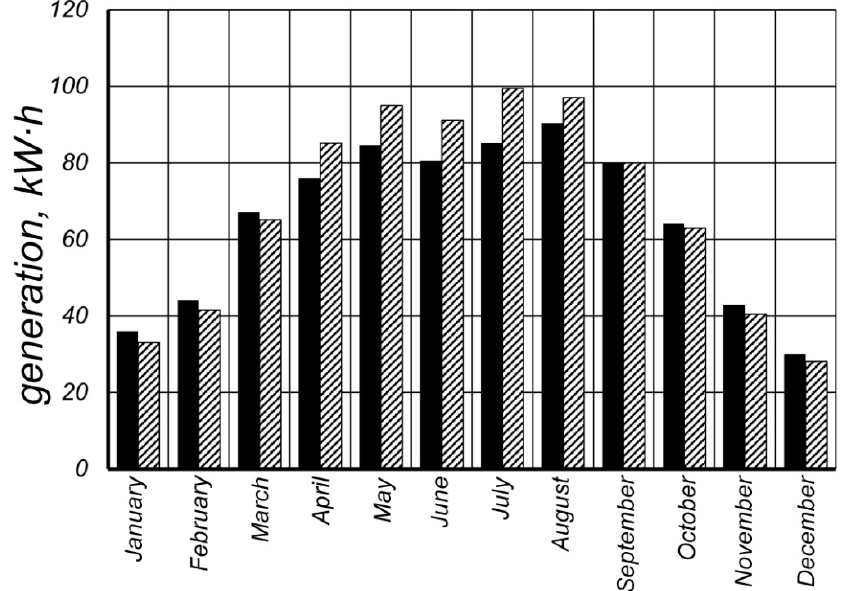
Figure 14. Diagram of monthly energy output of photovoltaic modules installed at an angle of 34° ▒ and 50° █ to the horizon.